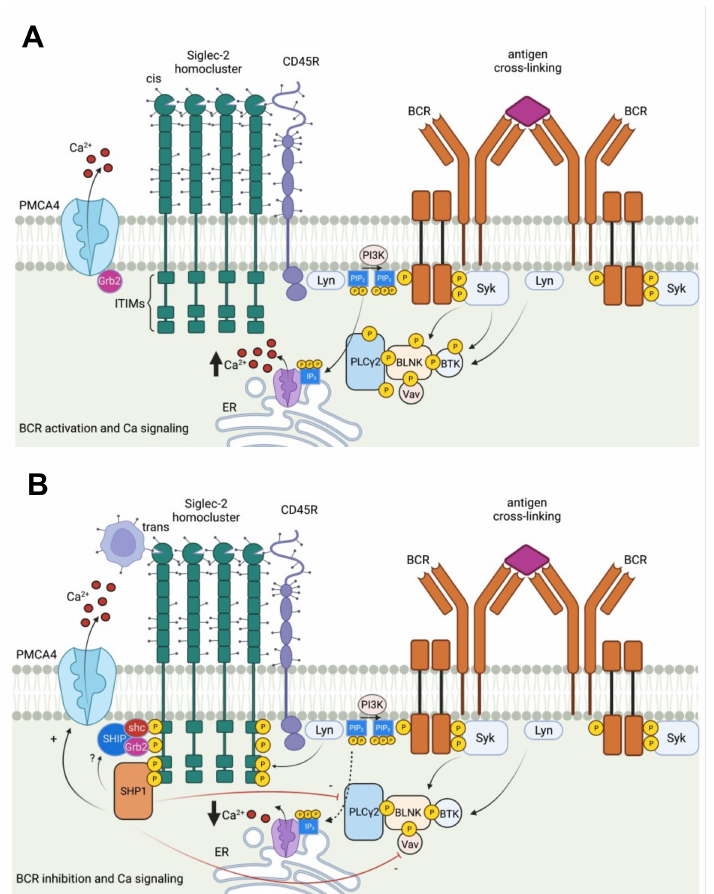
Figure 2. Activating and inhibitory pathways in Siglec-2 (CD22) as targets in cancer. ( A ) Antigen cross-linking of BCR results in an increase in cytosolic calcium in the B cells. Upon BCR stimulation, phosphorylation and activation of different BCR signaling complexes occur. Antigen binding is followed by the phosphorylation of ITAMs of Ig complex and PLC γ 2 mediated production of signaling molecule, inositol-1,4,5-triphosphate (IP3). IP3 binds to IP3 receptor on the endoplasmic reticulum (ER) to release Ca 2+ into the cytosol. Spleen tyrosine kinase (Syk) leads to increased phosphorylation of BTK-BLNK-PLC γ 2-VaV complex in the calcium cascade, which releases more Ca 2+ out of the ER. ( B ) Following BCR activation, cis or trans Siglec-2 recruitment inhibits BCR signaling and is phosphorylated by Lyn. There are six tyrosines in the intracellular tail of